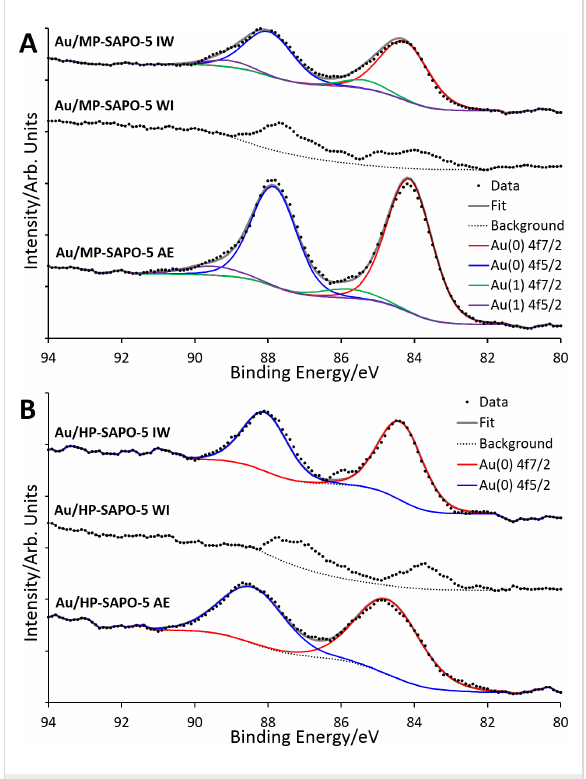
Figure 4: Stacked XPS data for Au-doped microporous MP-SAPO-5 (A) and hierarchical HP-SAPO-5 (B) showing the oxidation states present in the